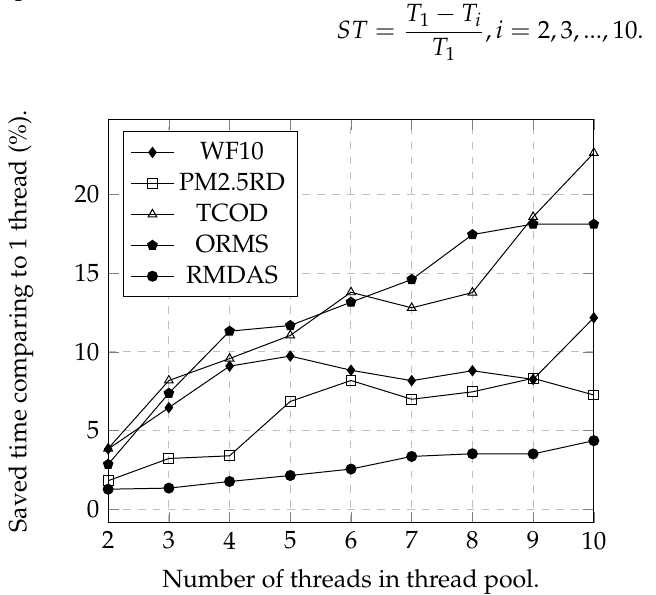
Figure 8. Saved time comparing to 1 thread for ingesting data with a fix-size thread